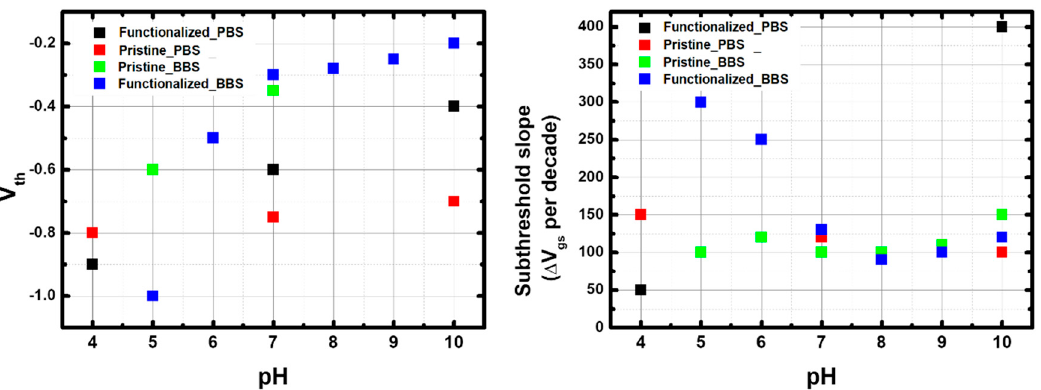
di ff erent pH from pH 10 to pH 4. V ds is fi xed at +0.8 V.